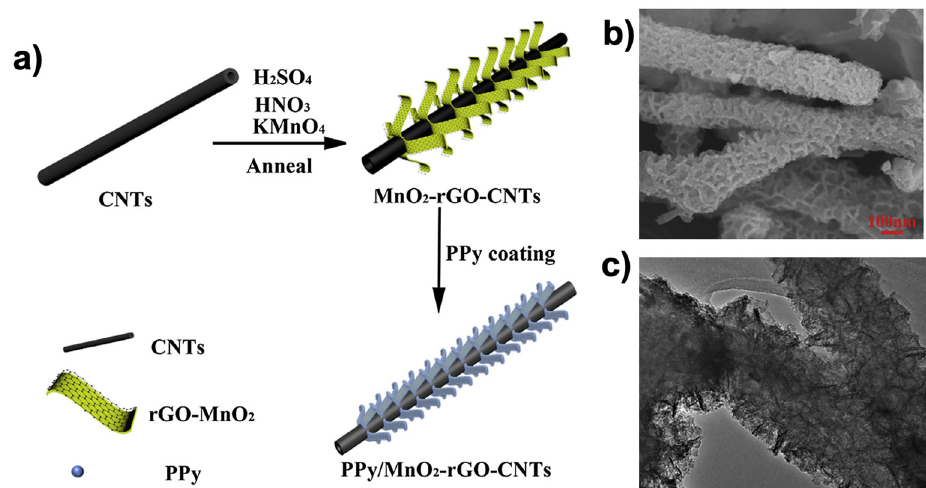
Figure 13. (a) Schematic illustration for the synthesis of the core-shell 3D structured Figure 13. ( a ) Schematic illustration for the synthesis of the core-shell 3D structured PPy/MnO2-rGO-CNTs composite. PPy/ MnO2-rGO-CNTs composite. ( b) SEM and ( c) TEM image of the PPy/MnO2-rGO-CNTs com- ( b ) SEM and ( c ) TEM image of the PPy/MnO2-rGO-CNTs composite. CNT: carbon nanotubes. Adapted with permission posite. CNT: carbon nanotubes. Adapted with permission from reference [237] , Copyright (2017) from reference [237], Copyright (2017) Elsevier.